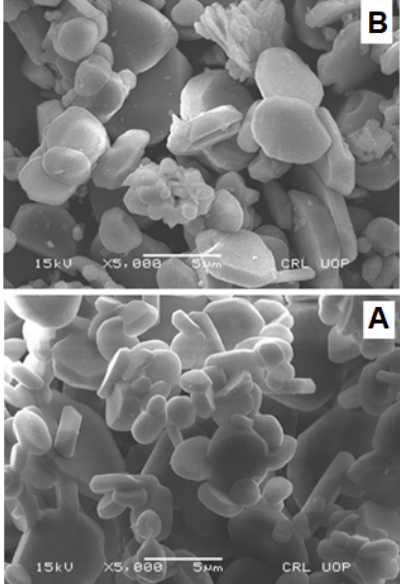
Figure 3: Scanning electron micrographs of prepared particles (a) Co O and (b) Ag-Co 3 4